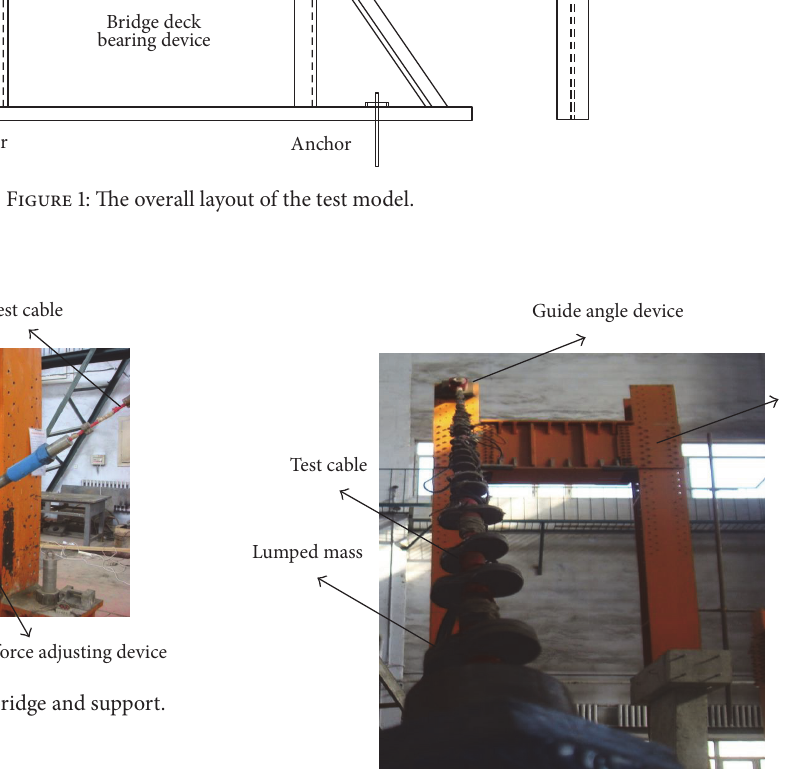
equivalent to solid round steel with diameter 0.036 m. At this time, the cable force sensor reads 0.27 V, and the calibration curve of sensor’s voltage and pull is shown in Figure